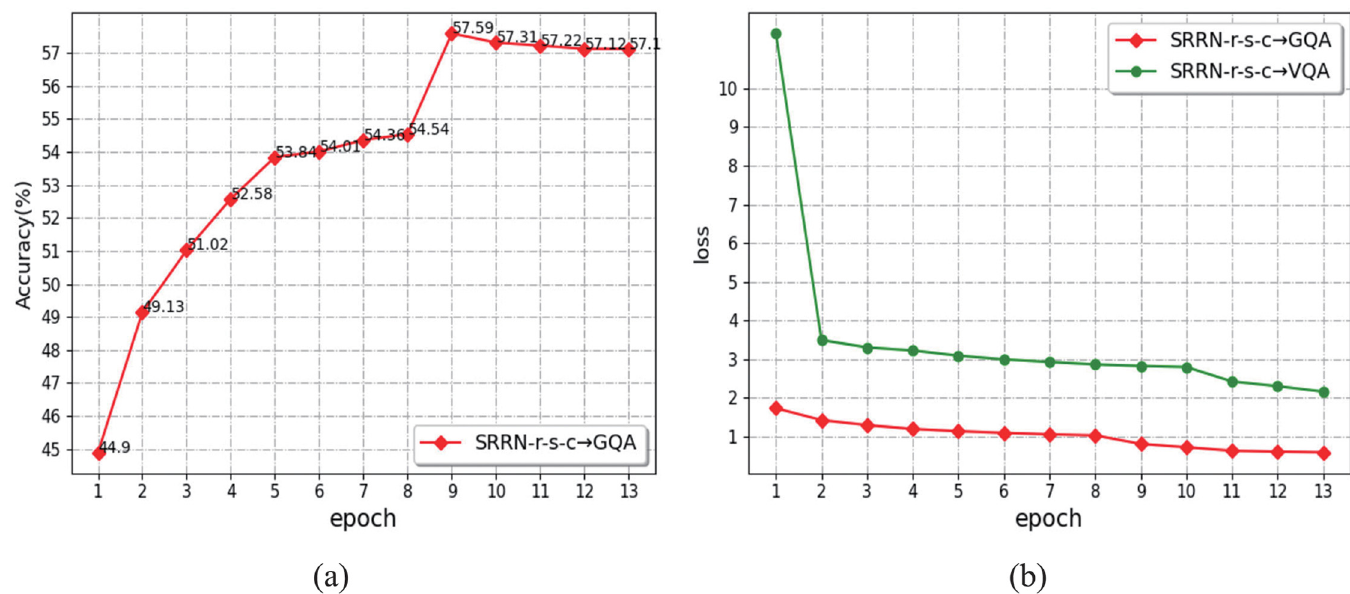
Fig 6. The change of accuracy and loss function in the process of model